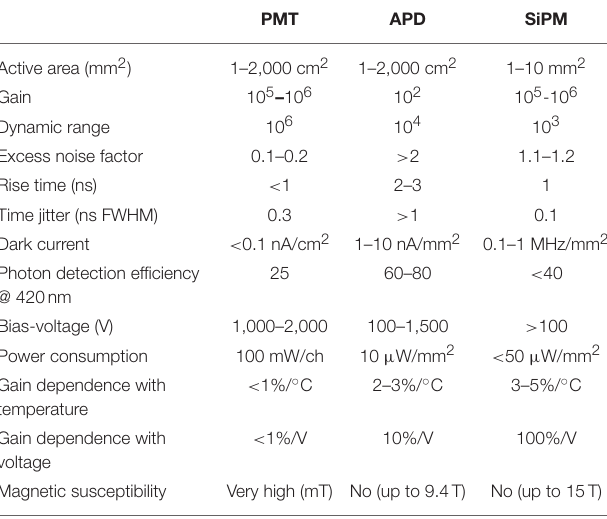
TABLE 4 | Characteristics of photo-detectors used in medical imaging applications (adapted from Lecomte [79]). PMT APD SiPM Active area (mm 2